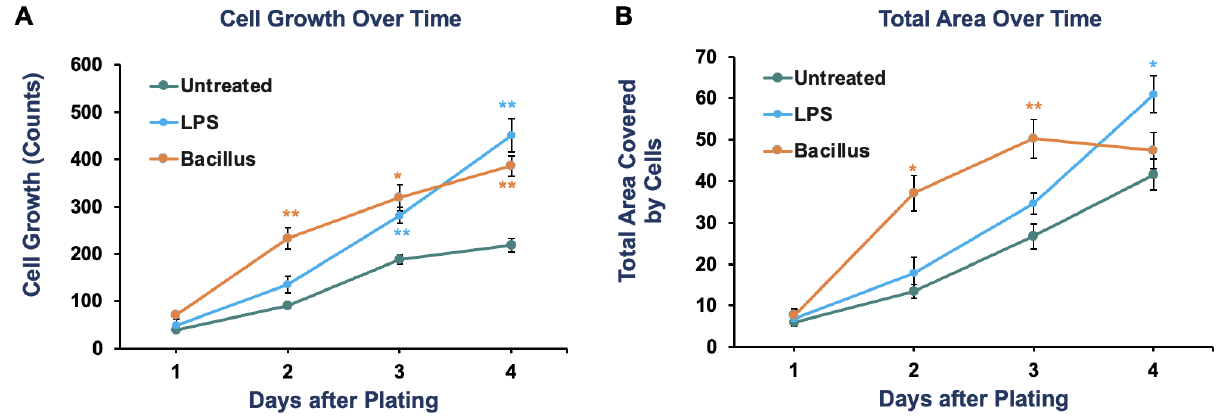
Figure 3. The effect of Bacillus or lipopolysaccharide (LPS; 10 ng/mL) on the growth of colorectal cancer cells (HCT 116) over time is quantified daily by imaging two to three independent areas of a cell culture chamber. The number of cells in images was counted using Image J. The data represents the average quantification with a standard error of 4 – 5 images as cell counts ( A ) and area covered by cells ( B ). These experiments were performed without hypoxic conditions. Student t -test was used to calculate the p -value. * p < 0.05 and ** p < 0.01.